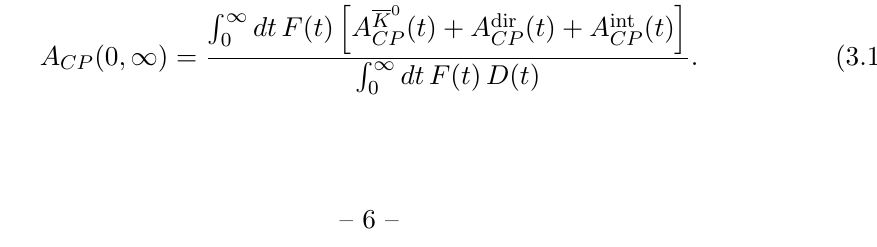
! pK ( t )( ! (cid:25) + (cid:25) (cid:0) c